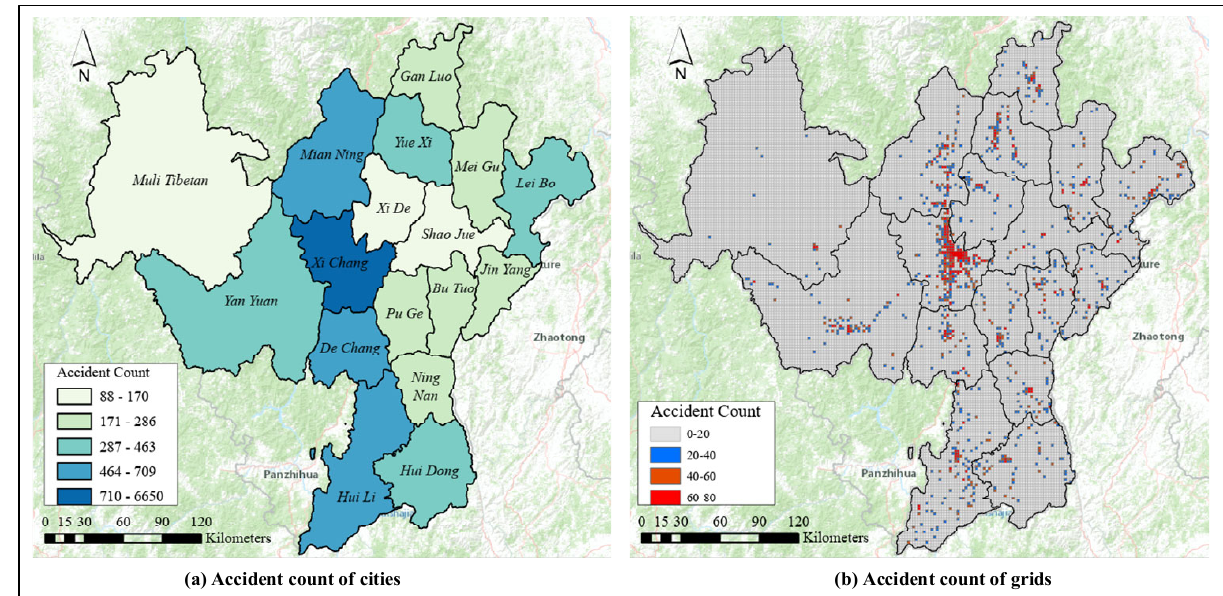
Figure 2. Distribution of traffic accidents: ( a ) accident count of cities, ( b ) accident count of grids (200 m × 200 m).